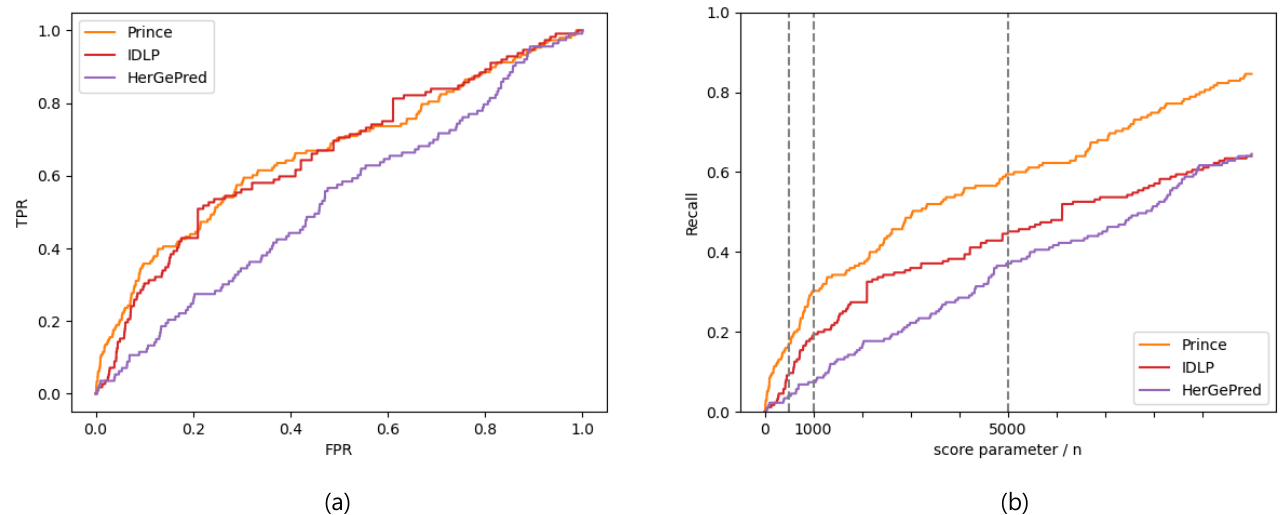
Figure 4. ROC ( a ) and recall ( b ) curves evaluated by prediction scores for disease-gene association prediction without known disease-associated